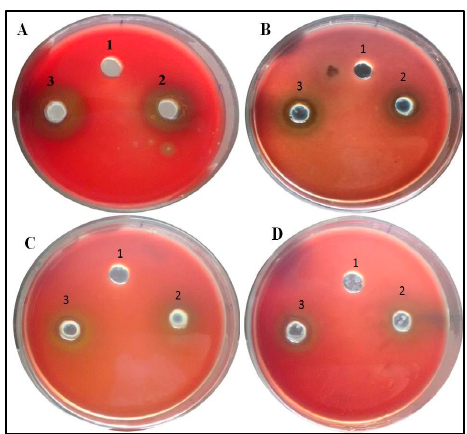
Figure 8. Images representative of Anti-proteolytic effect of ZnO NPs. Zone size decreases as the concentration increases. Well (1) represents Nutrient Broth, well (2) PAO1 culture, and well (3) Clinical isolate. ( A ) Control, ( B ) 100 µg/mL of ZnO amended, ( C ) 200 µg/mL of ZnO amended, ( D ) 300 µg/mL of ZnO amended.